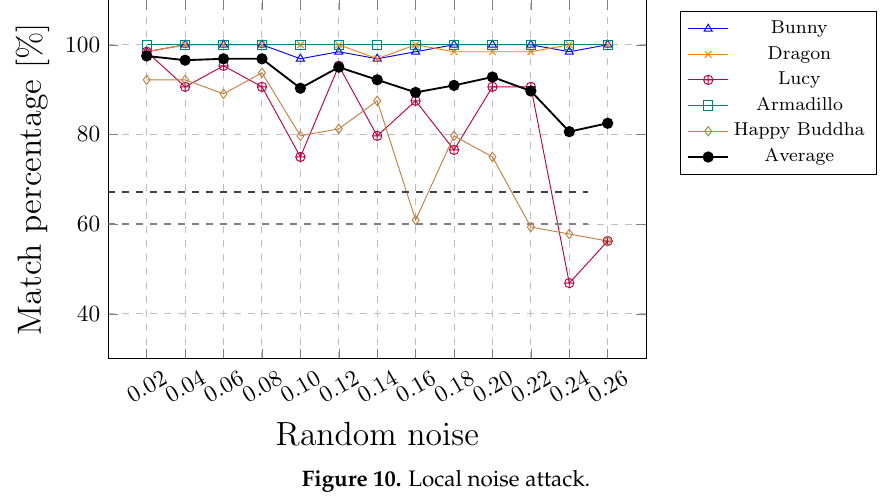
Figure 10. Local noise